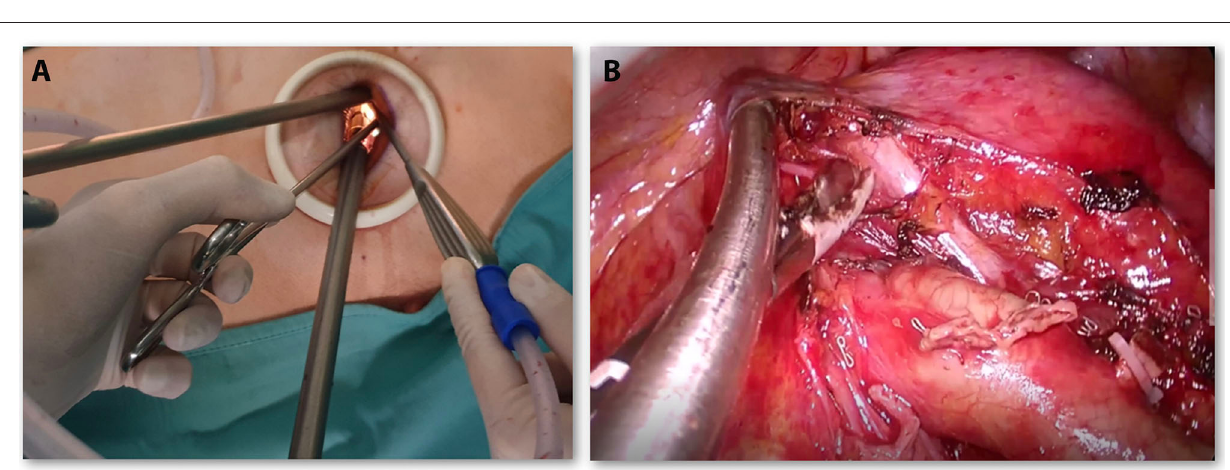
regression was performed to evaluate any possible risk factor for nodal upstaging. Any variable with a p < 0.20 at univariate analysis was included in the multiple regression model to detect the independent risk factors for lymph nodal